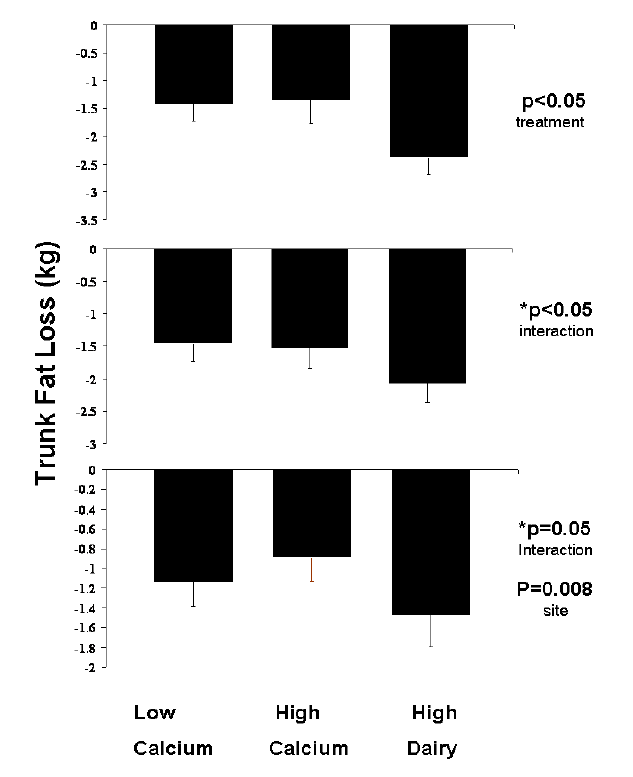
Figure 4. Effects of dietary treatments on trunk fat loss. Top panel: Adherent subjects. Middle panel: All subjects completing the study. Bottom panel: Intent-to-treat analysis. All data are presented as mean ± standard